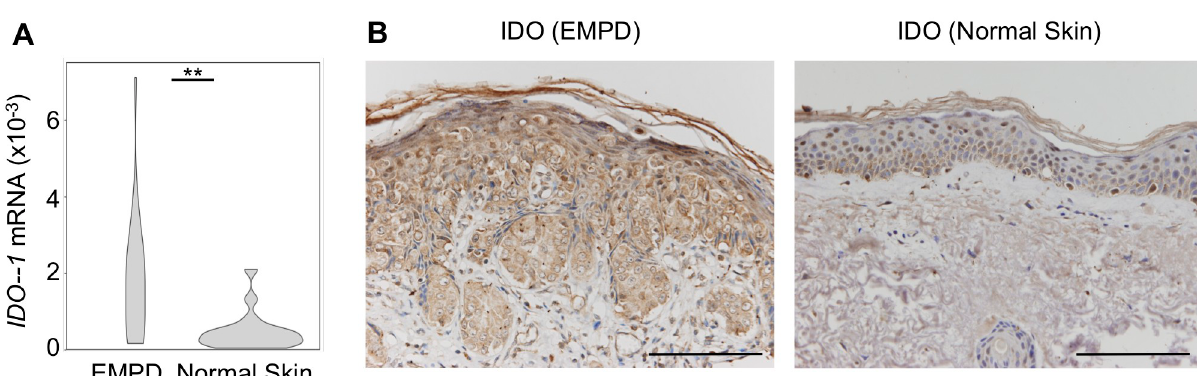
Fig 5. IDO expression at the tumor site. (A) mRNA expression of IDO1 in tumor samples (n = 28) and normal skin samples (n = 18) using violin plots. (B) IHC of IDO in tumor samples and in normal skin samples. P- value was calculated by the Mann-Whitney U test between tumor samples and normal skin samples. Double asterisks indicate P < 0.01, scale bar, 100 μ m.